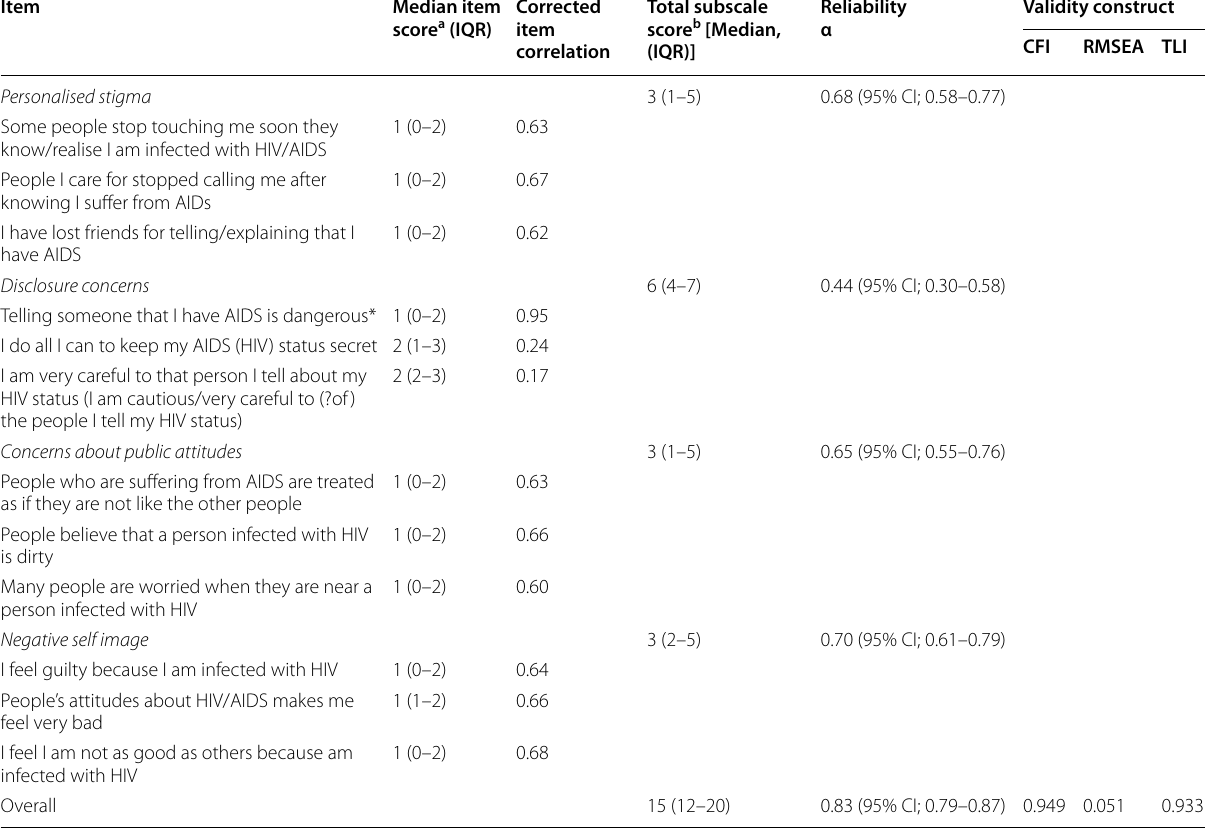
Table 2 Descriptive statistics for the short-form version (HSS-12) of the HIV Stigma Scale